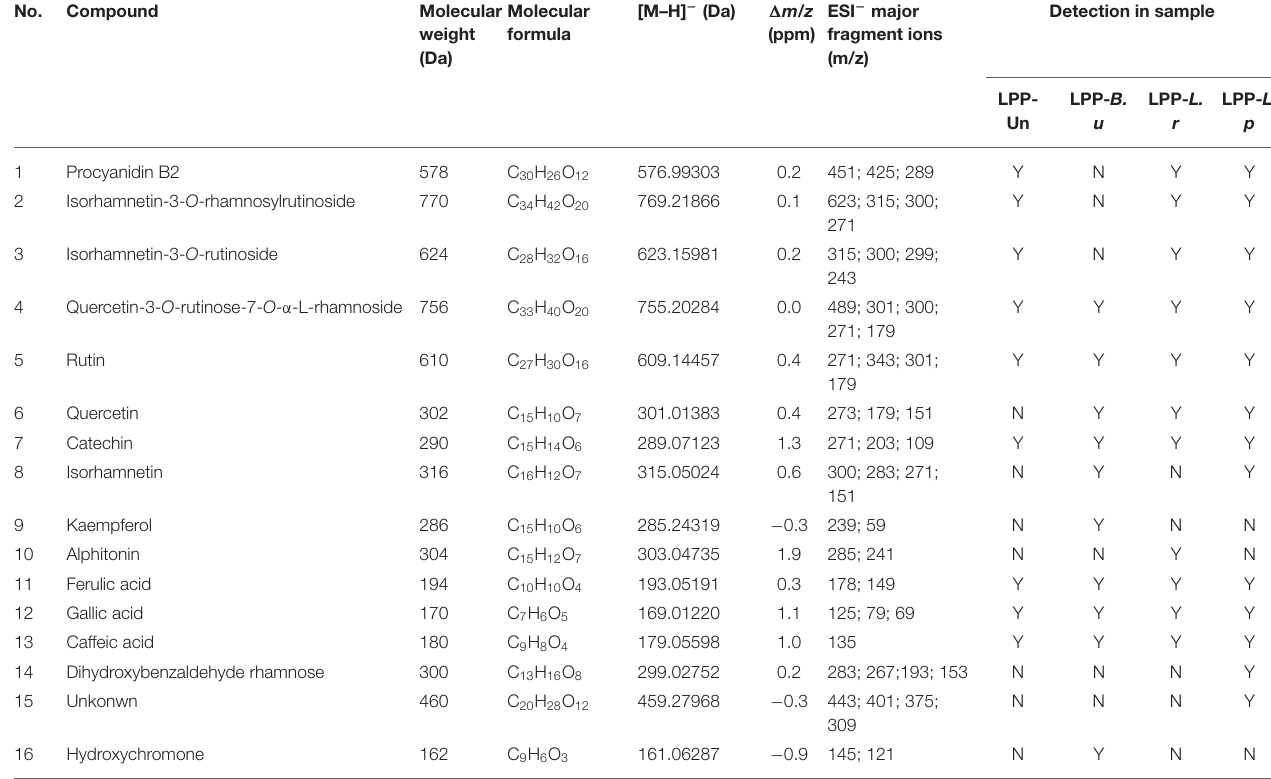
TABLE 2 | Metabolites of lychee pulp phenolics in microbial cultures over 48h fermentation a . No.